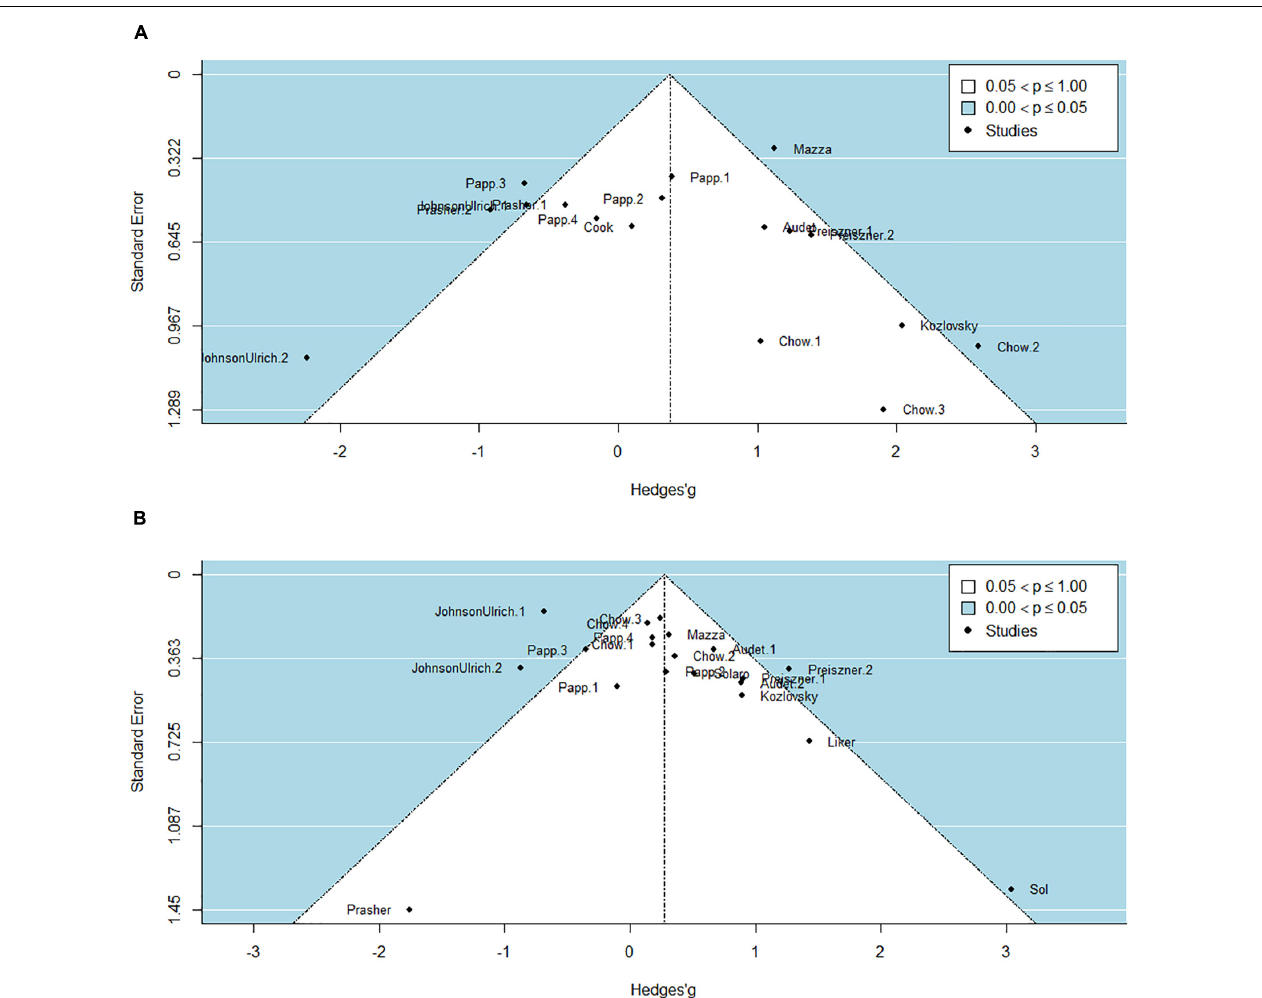
FIGURE 4 | Funnel posts for testing potential publication bias and outliers for solving success odds ratios (A) and solving latency estimates (B)